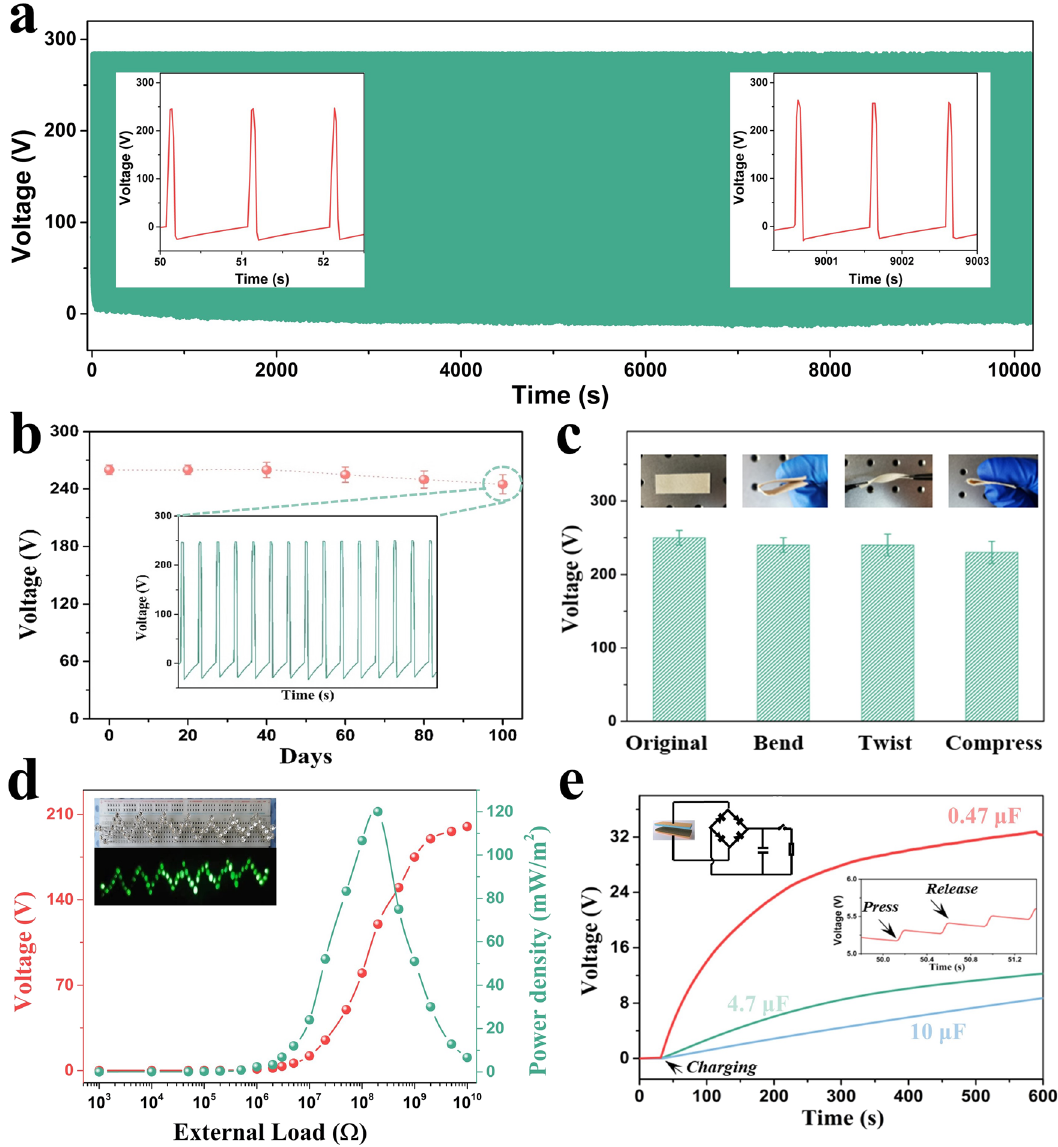
Fig. 4 Stability and charging pro fi le of triboelectric sensor. a Endurance of AF@VMT-5 TENG over 10,000 cycles at 1 Hz. Inset shows the partial enlargement of the test around 50 s and 9000 s. b Long-term stability of AF@VMT-5 paper TENG, inset shows a partial enlargement of the test after 100 days. c Output performance of TENG before and after arbitrary deformation under repeated compressive force at 1 Hz. d Output power density and voltage of the AF@VMT-5 TENG with different external load resistances, about 70 small bulbs connected in series can be lit by the device, as shown in the illustration. e Charging pro fi le of different capacitors by using the AF@VMT-5 TENG. Inset shows the enlarged detailed view of the capacitor charging concentration data the model has not previously seen. In addition, the confusion matrix for nine different types of motion from the we further optimize the training model to return the prede fi ned KNN classi fi cation results ( K = 2, Supplementary Fig. 6), showing a discrete prediction levels instead of a linear prediction surface prediction accuracy of 96.2%. Consequently, this is able to express consistent with the mean of a probability distribution. The the decision boundary map as a function of 2D PC coordinates predicted results of the joint fl exion angle are shown in Fig. 6d. with excellent visibility and prediction accuracy of the training model. To build a training model for predicting the bending angle, the fi tting line (black dashed line) by Eq. (2) as follows: a regression model is trained for different angles using linear regression from the Sklearn machine-learning library without data on the middle angle of the bend (about 60°). To evaluate the performance of the training model, we carefully divide the dataset into two categories for training and validation (untrained). In order where y is the real value, p is the predicted value, and y is the to predict intermediate angles, larger and smaller angles are used average of the actual values at the corresponding joint bending angle speci fi ed, y-p can be described as a residual scatter from the prediction of the real value through the machine-learning untrained dataset to verify the validity of the predicted